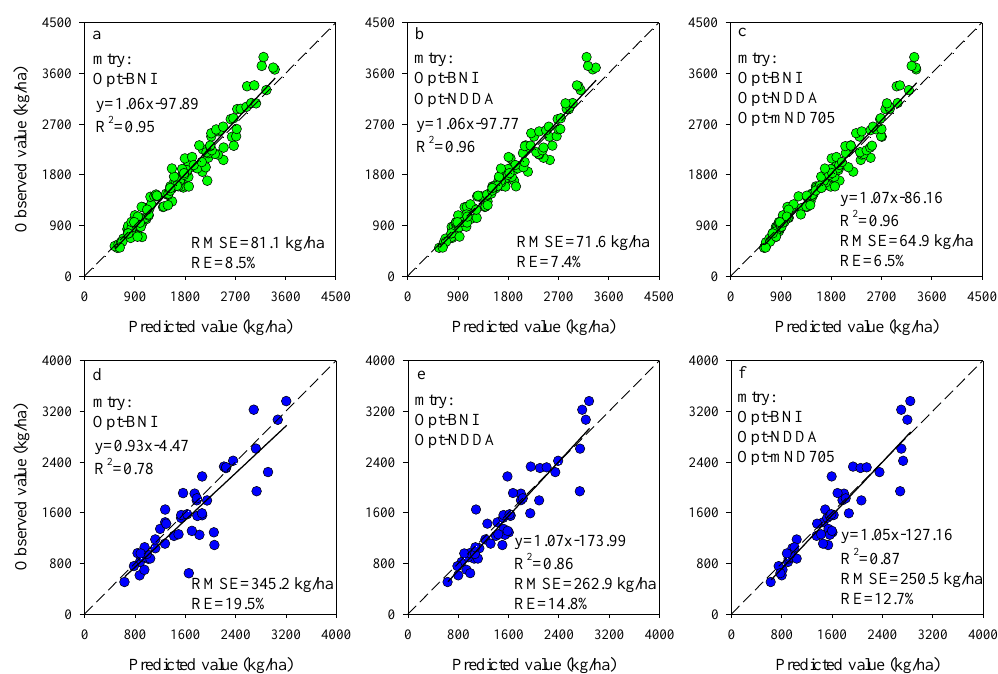
Figure 11. Optimizing the number of Opt-SIs predictors according to important scores at the combination of growth stage for training dataset ( a – c ) and testing dataset ( d – f ).